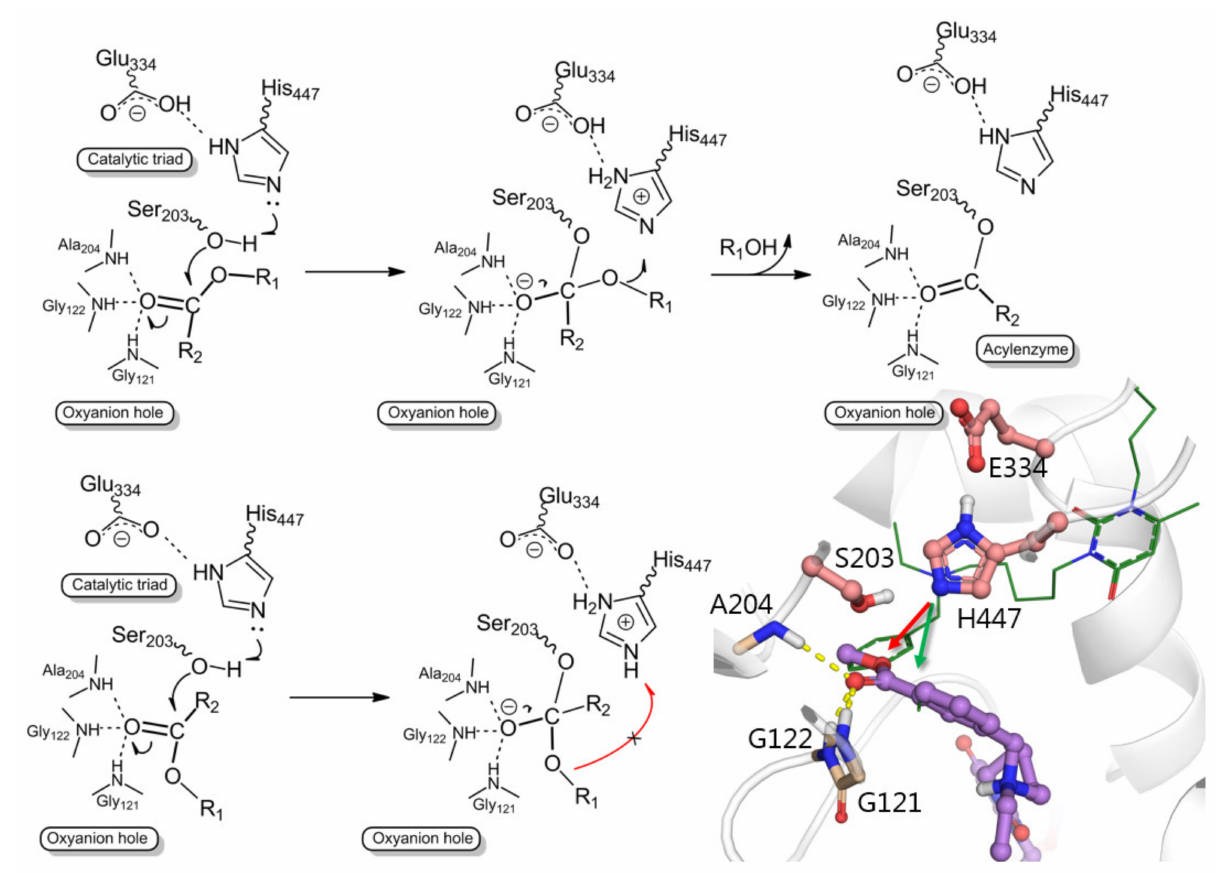
Figure 5. Mechanism of hydrolysis of an ester group with various orientation of the substrate relative the catalytic triad. Ball and stick representation with carbon atoms colored violet show docked position of compound 2c . Line representation with carbon atoms colored green show hypothetical position of compound 2c favorable for hydrolysis, but colliding with the